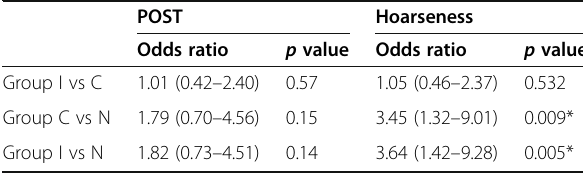
Table 2 Odds ratio with 95% confidence interval POST Hoarseness Odds